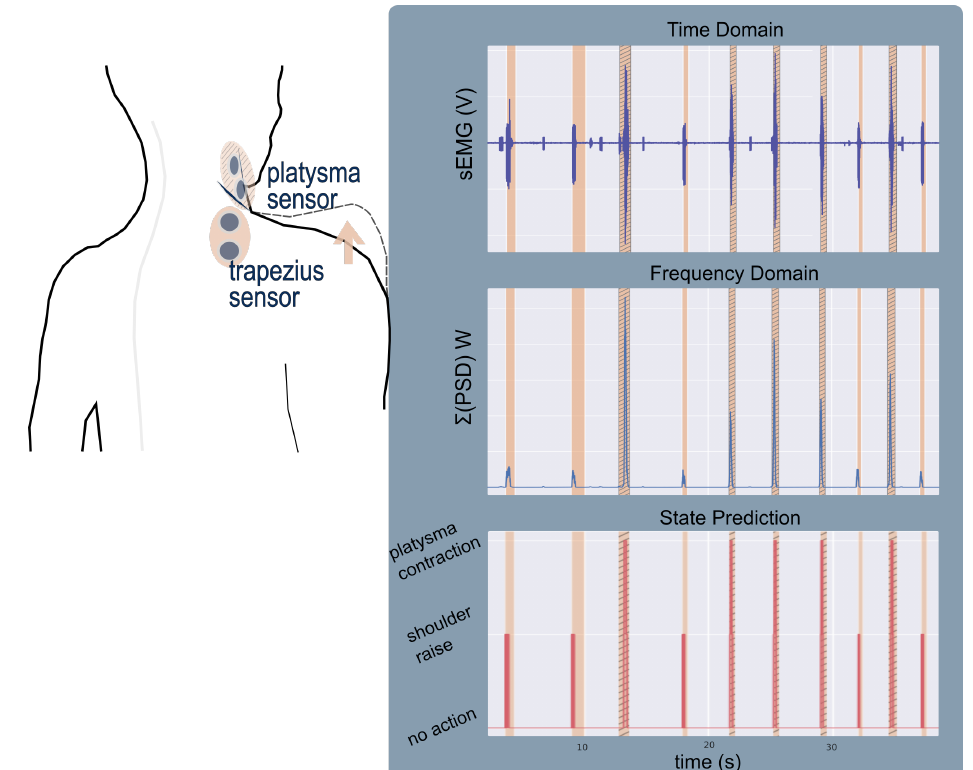
Figure 13. From top to bottom: The filtered EMG readings, the power of the signal and the state- prediction results from a sample of Participant2 data. The shaded regions represent the event occurrences; the hatched shaded regions indicate a platysma contraction and the non-hatched ones a shoulder raise